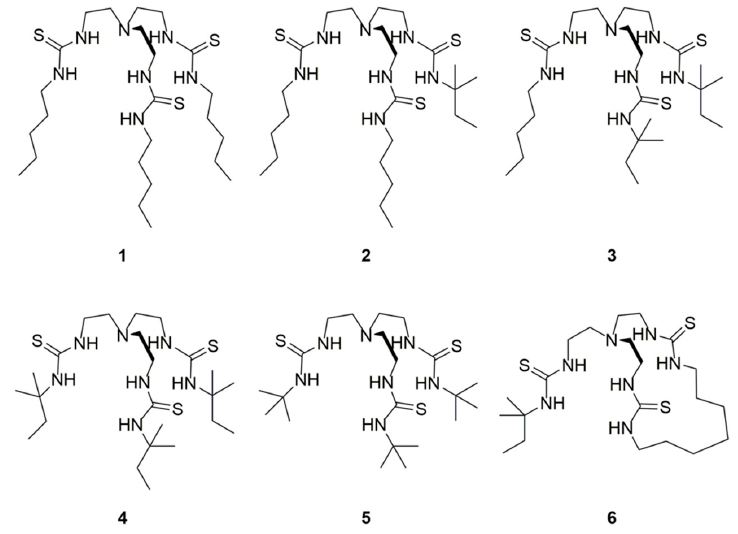
Figure 1. Structure of receptors 1 – 6 .